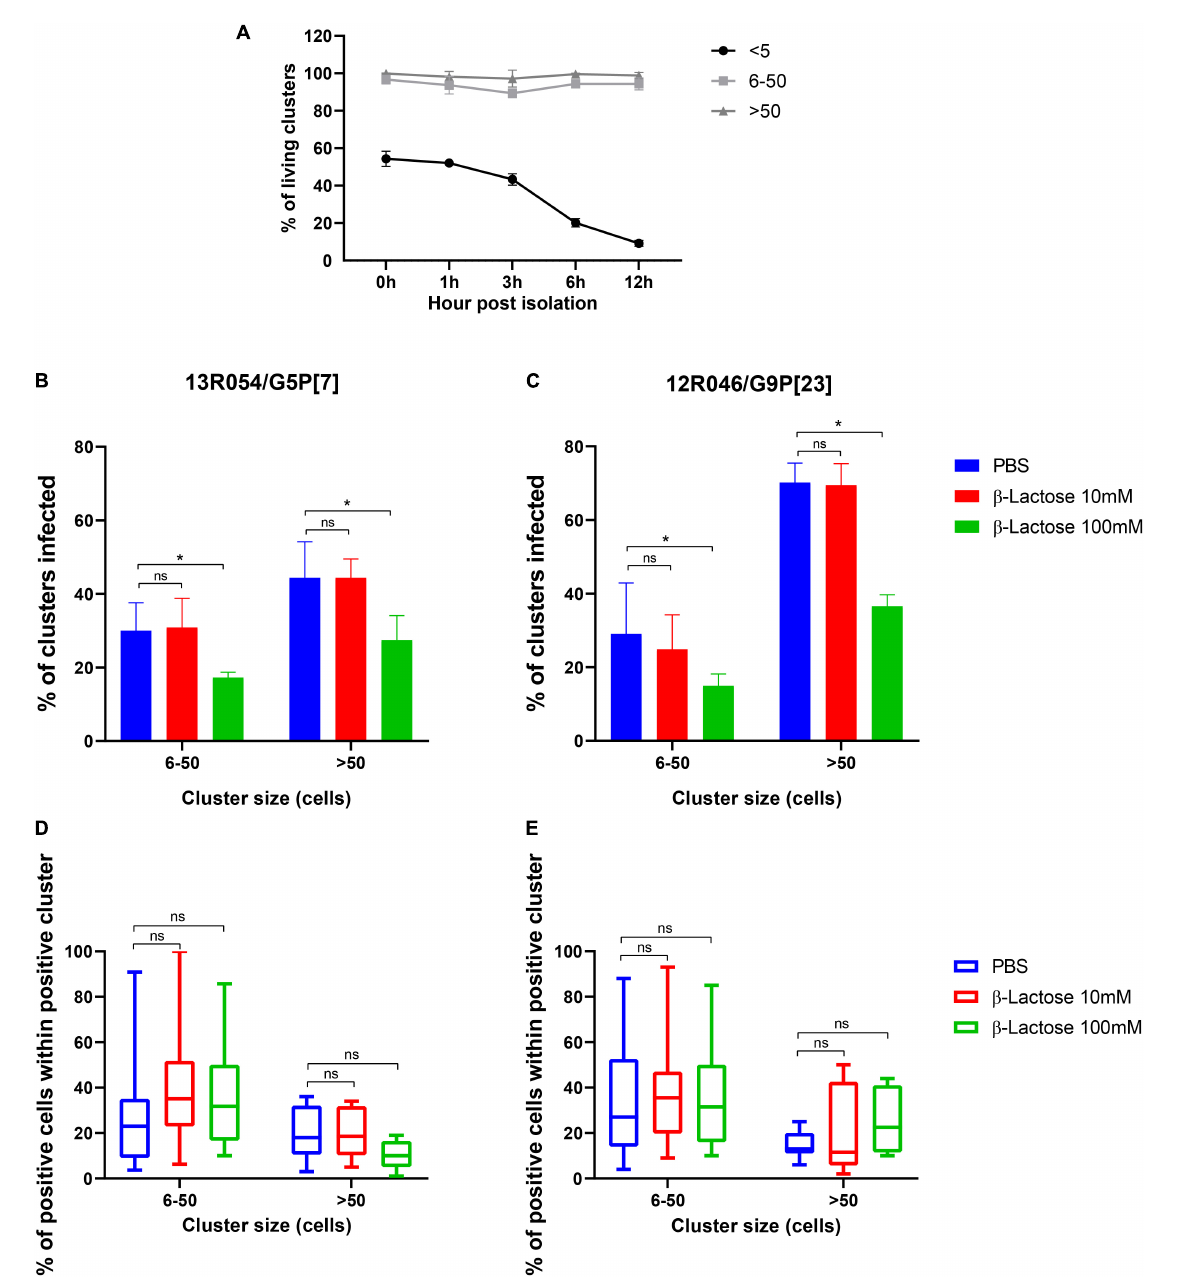
FIGURE7 β -lactose pretreatment decreases the replication of rotavirus in porcine enterocytes. After isolation, the ileum enterocytes were incubated with lactose pretreated RVAs for 12 h. (A) The viability of clusters during incubation was checked with EMA. The percentage of infected clusters (B-13R054 G5P[7] and C-12R046 G9P[23]) and the percentage of infected cells in a single cluster (D-13R054 G5P[7] and E-12R046 G9P[23]) were determined. (A–C) The error bars in the figures represent the means ± the SD from triplicate experiments. (D,E) The error bars in the figures represent the min to max. * P < 0.05. ns, P >